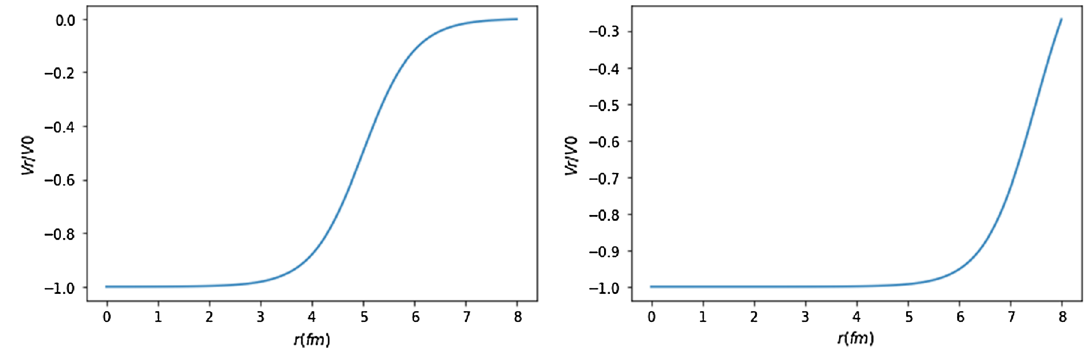
Fig. 1 Woods Saxon potential for two different radius. We have taken the parameters a = 0 . 5 f m and the radius a 0 to be 5 f m for the left and 7 f m for the right